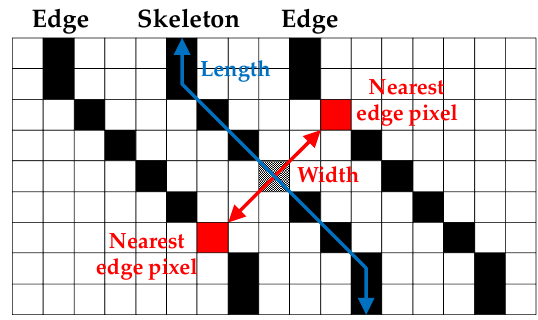
Figure 2. Illustration of crack width and length calculation.